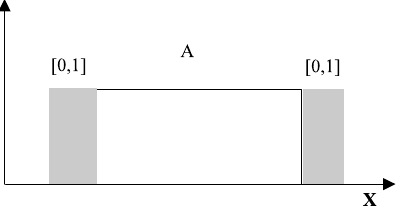
Figure 9. An example of a shadowed set A; note shadows formed around the cores of the construct